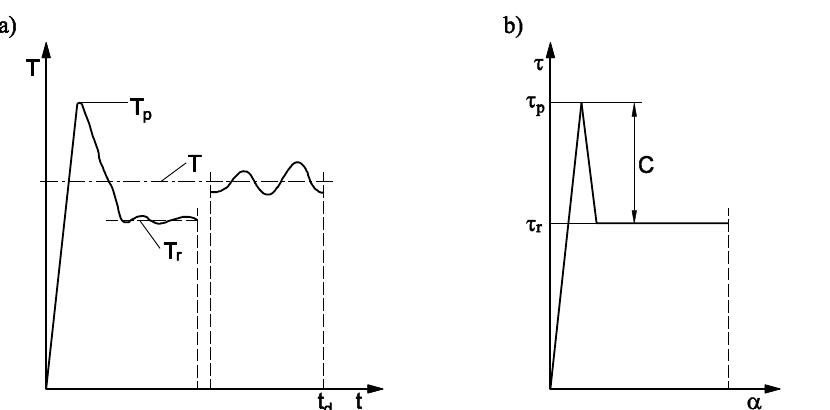
Figure 3. Torque diagram ( a ) and fine cohesive material behaviour in a shear test ( b ). For non-cohesive materials component C → 0 and τ p = τ r .